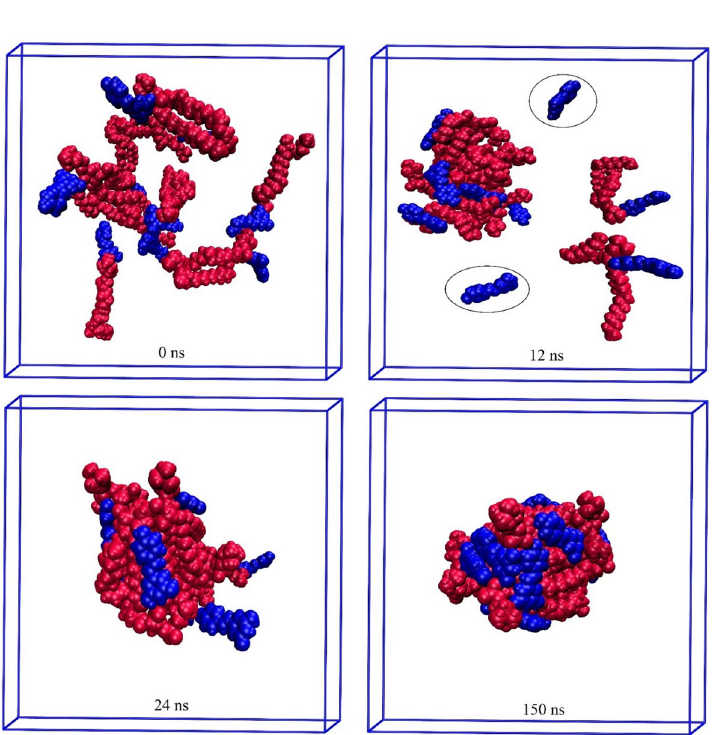
Figure 13. Self-aggregation process of Re-PC monomers into a phytosome as a function of MD simulation time. Color code; Re: blue and PC: